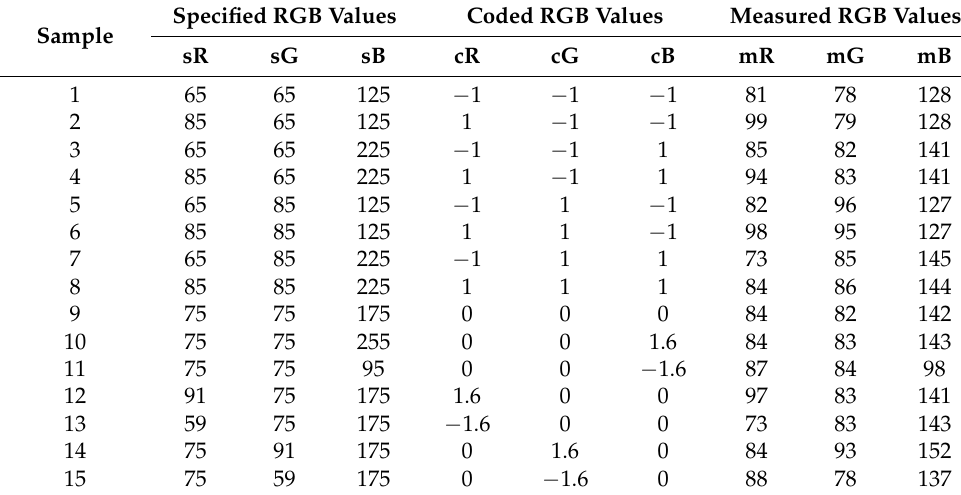
Table A4. CCD matrix and results for Case 4.